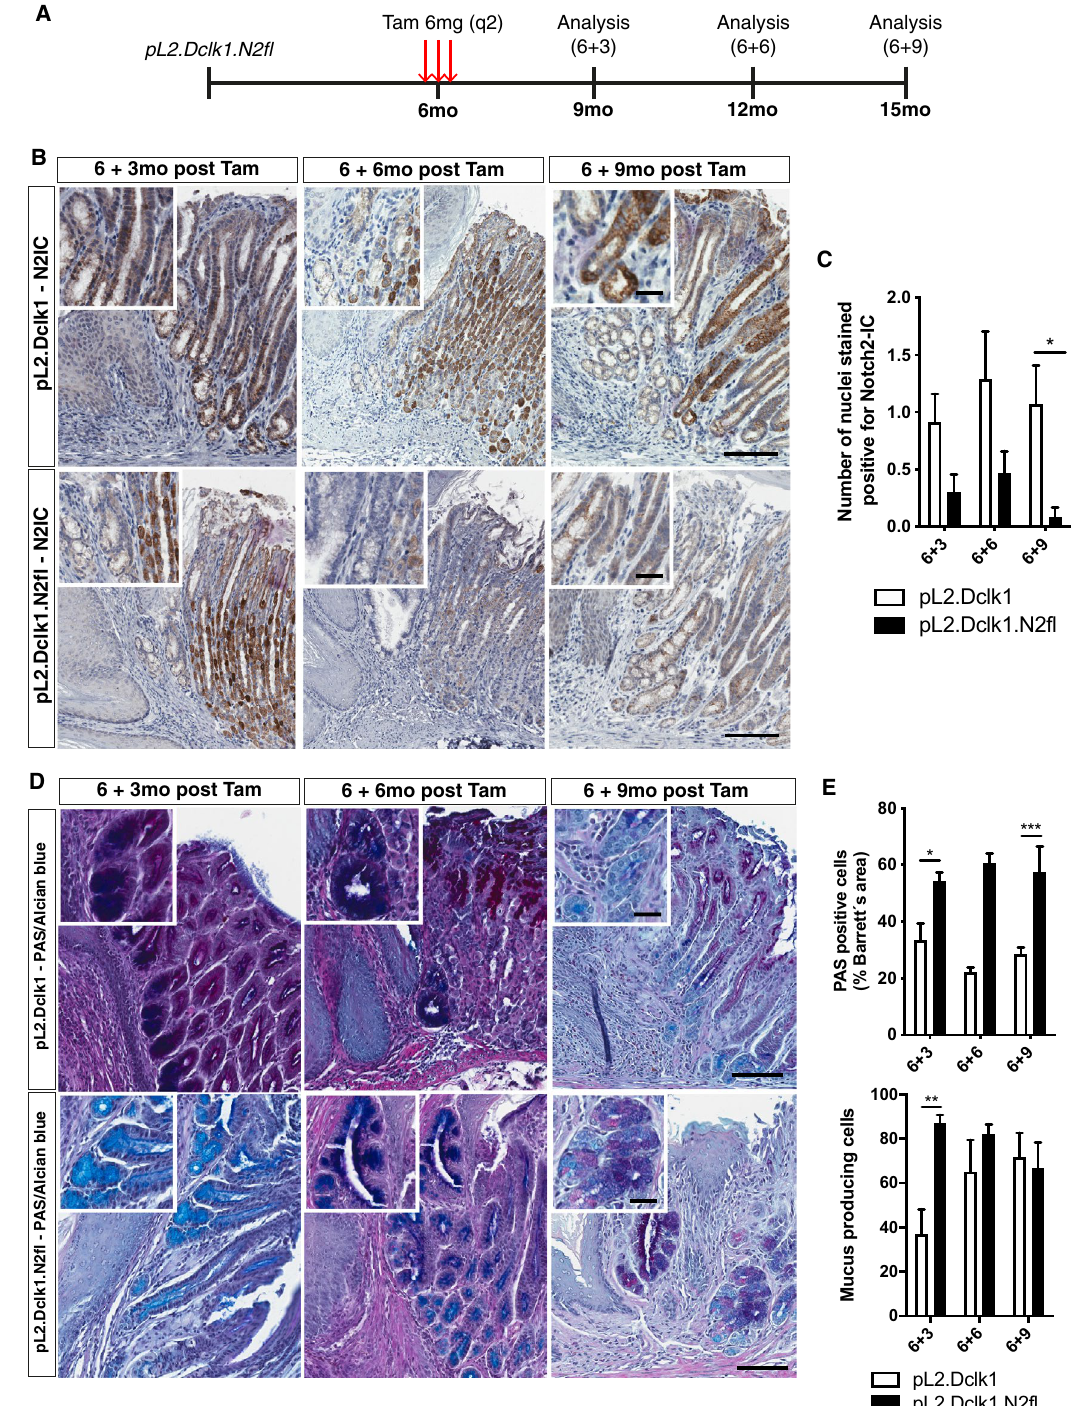
Figure 3. Genetic ablation of the Notch 2 receptor in Dclk1-positive gastric tuft cells decelerates BE progression. ( A ) Experimental scheme illustrating timepoints of Tamoxifen induction and tissue collection for analysis. ( B ) Representative stainings for Notch2-IC of the SCJ of pL2.Dclk1 and pL2.Dclk1.N2fl mice, respectively; scale bars = 200 µm; insets scale bar = 50 µm; for pL2.Dclk1, at 6 + 3 and 6 + 6 the same pictures are shown as in Fig. 2A for comparison to pL2.Dclk1.N2fl tissues. ( C ) Histopathologic scoring of Notch2-IC stained nuclei in pL2.Dclk1.N2fl tissues compared to pL2.Dclk1 controls (6 + 3 n = 10 pL2.Dclk1.N2fl, n = 11 pL2.Dclk1 controls; 6 + 6 n = 15 pL2.Dclk1.N2fl, n = 7 pL2.Dclk1 controls; 6 + 9 n = 12 pL2.Dclk1.N2fl, n = 14 pL2.Dclk1 controls, ordinary two-way ANOVA, p = 0.014). ( D , E ) Histopathologic analysis and scoring in pL2.Dclk1.N2fl tissues compared to pL2.Dclk1 controls for PAS-positive cells at the SCJ (6 + 3 n = 6 pL2.Dclk1.N2fl, n = 6 pL2.Dclk1 controls, ordinary two-way ANOVA, p = 0.017; 6 + 6 n = 9 pL2.Dclk1.N2fl, n = 2 pL2.Dclk1 controls; 6 + 9 n = 5 pL2.Dclk1.N2fl, n = 7 pL2.Dclk1 controls, ordinary two-way ANOVA, p = 0.0009) and mucous producing cells (6 + 3 n = 5 pL2.Dclk1.N2fl, n = 6 pL2.Dclk1 controls, ordinary two-way ANOVA, p = 0.0057; 6 + 6 n = 9